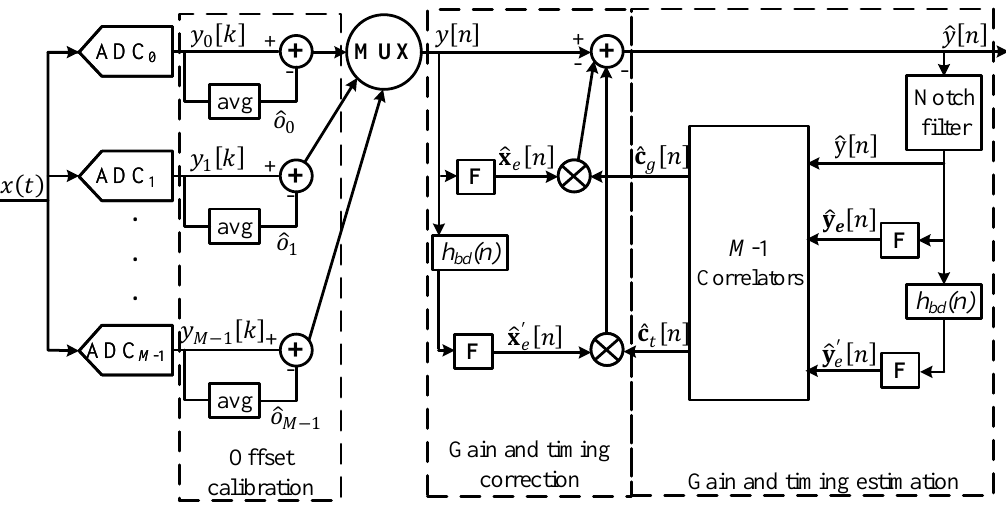
Figure 3. Proposed scheme for multiple channel mismatches’